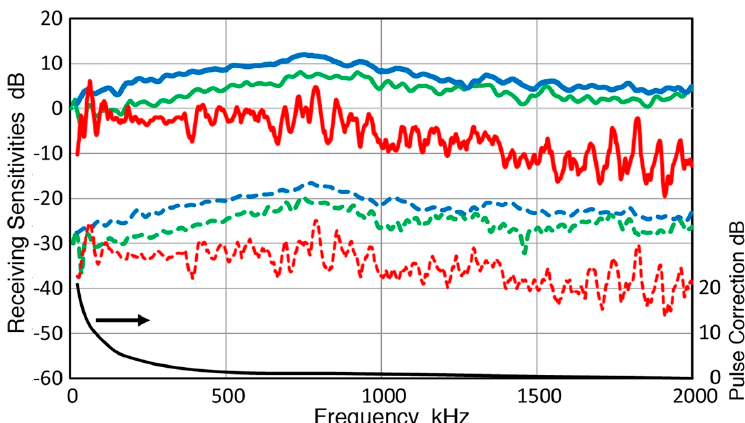
Figure 13. Receiving sensitivities of reference KRN sensors to three wave modes, NW (blue curves), RW (green curves) and other guided waves (GW, red curves). NW and RW sensitivities are from Figure 9. Previous GW receiving sensitivities [28,29] were corrected using spectral difference of two-pulse shapes, shown by black curve (use the right scale). Solid curves for KRNBB-PC and dash curves for KRNBB-PCP sensors. Use the left scale for all curves in color.